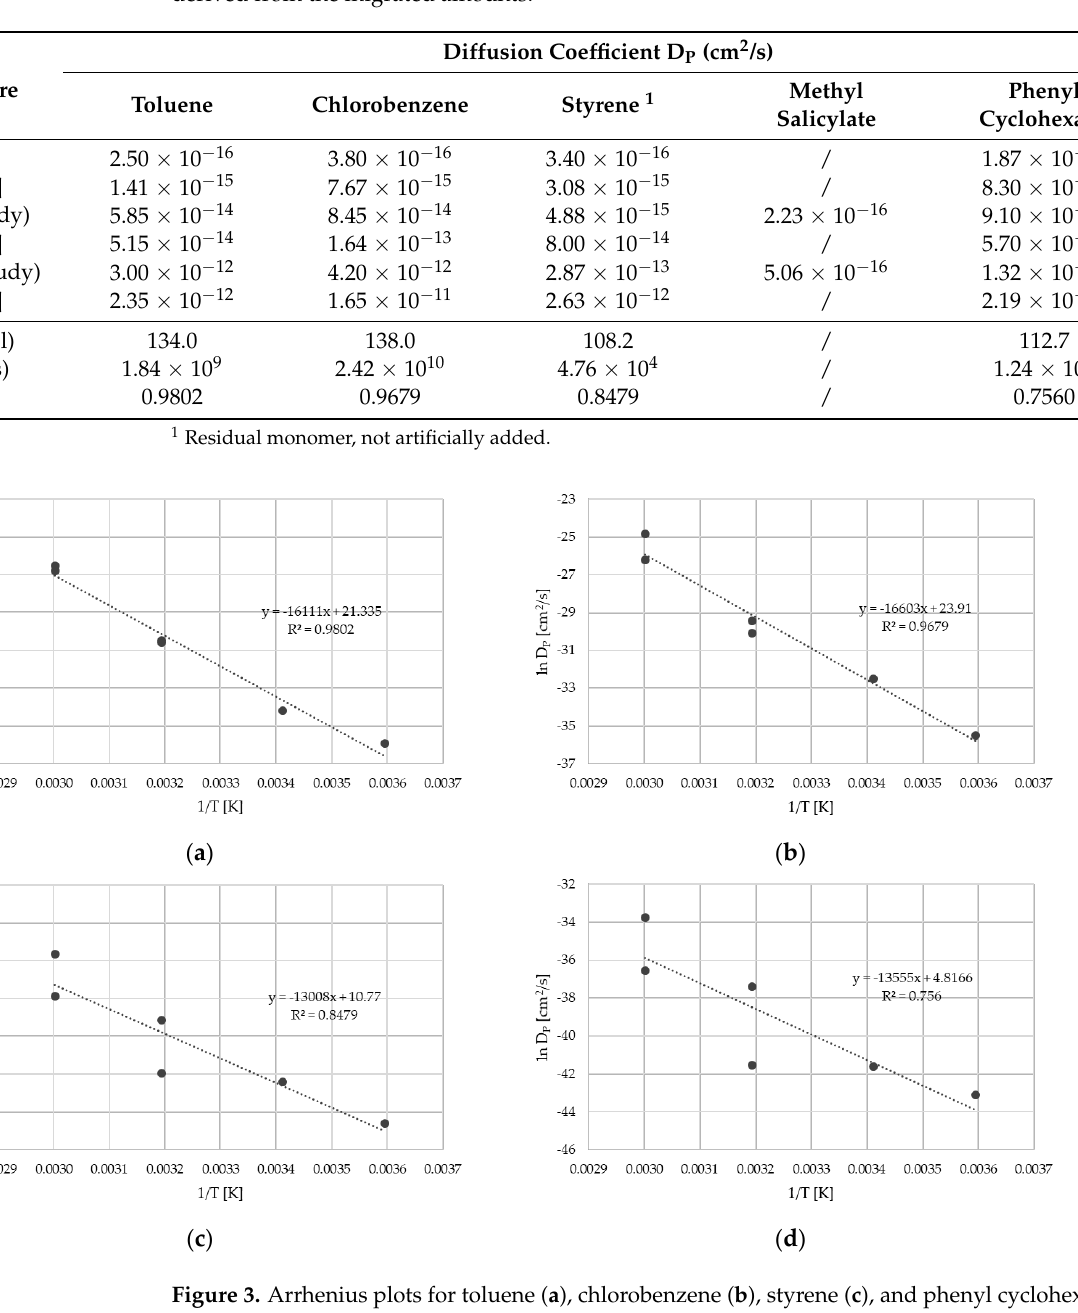
Table 4. Diffusion coefficients D P , activation energies of diffusion E A , and pre-exponential factor D 0 derived from the migrated amounts.